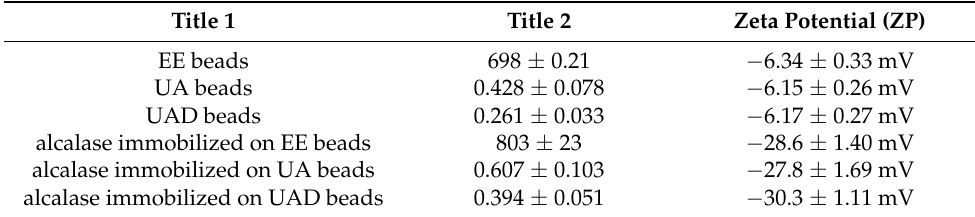
Table 1. Beads diameter and zeta